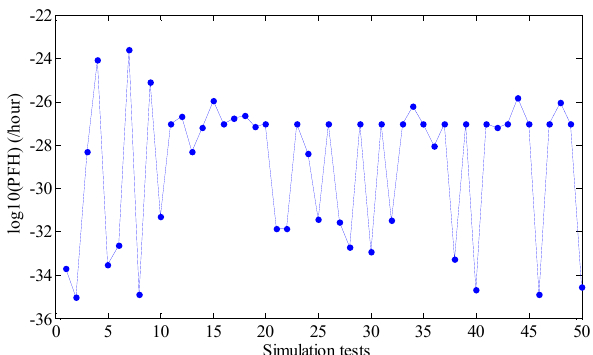
Figure 15. The PFH in 50 sets of simulation tests.